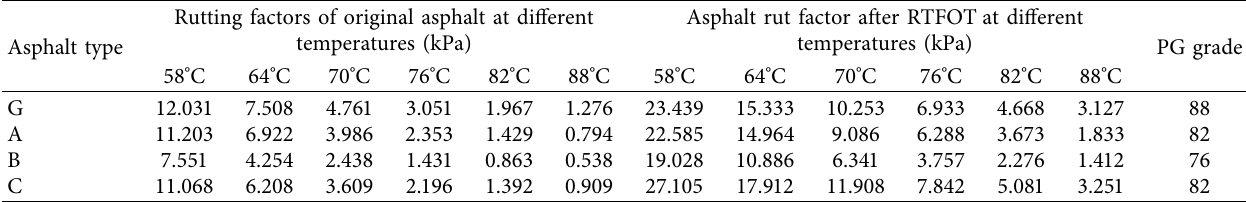
Table 11: High-temperature classification results of modified